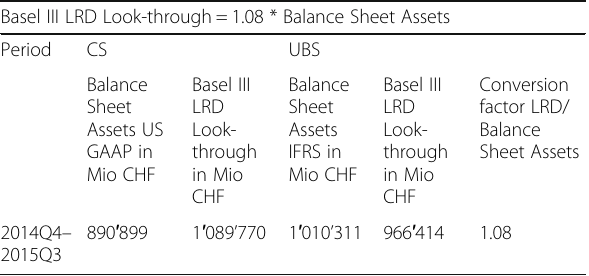
the full application of Basel III, excluding the phase-in adjustment of the transition period from 2014 up to